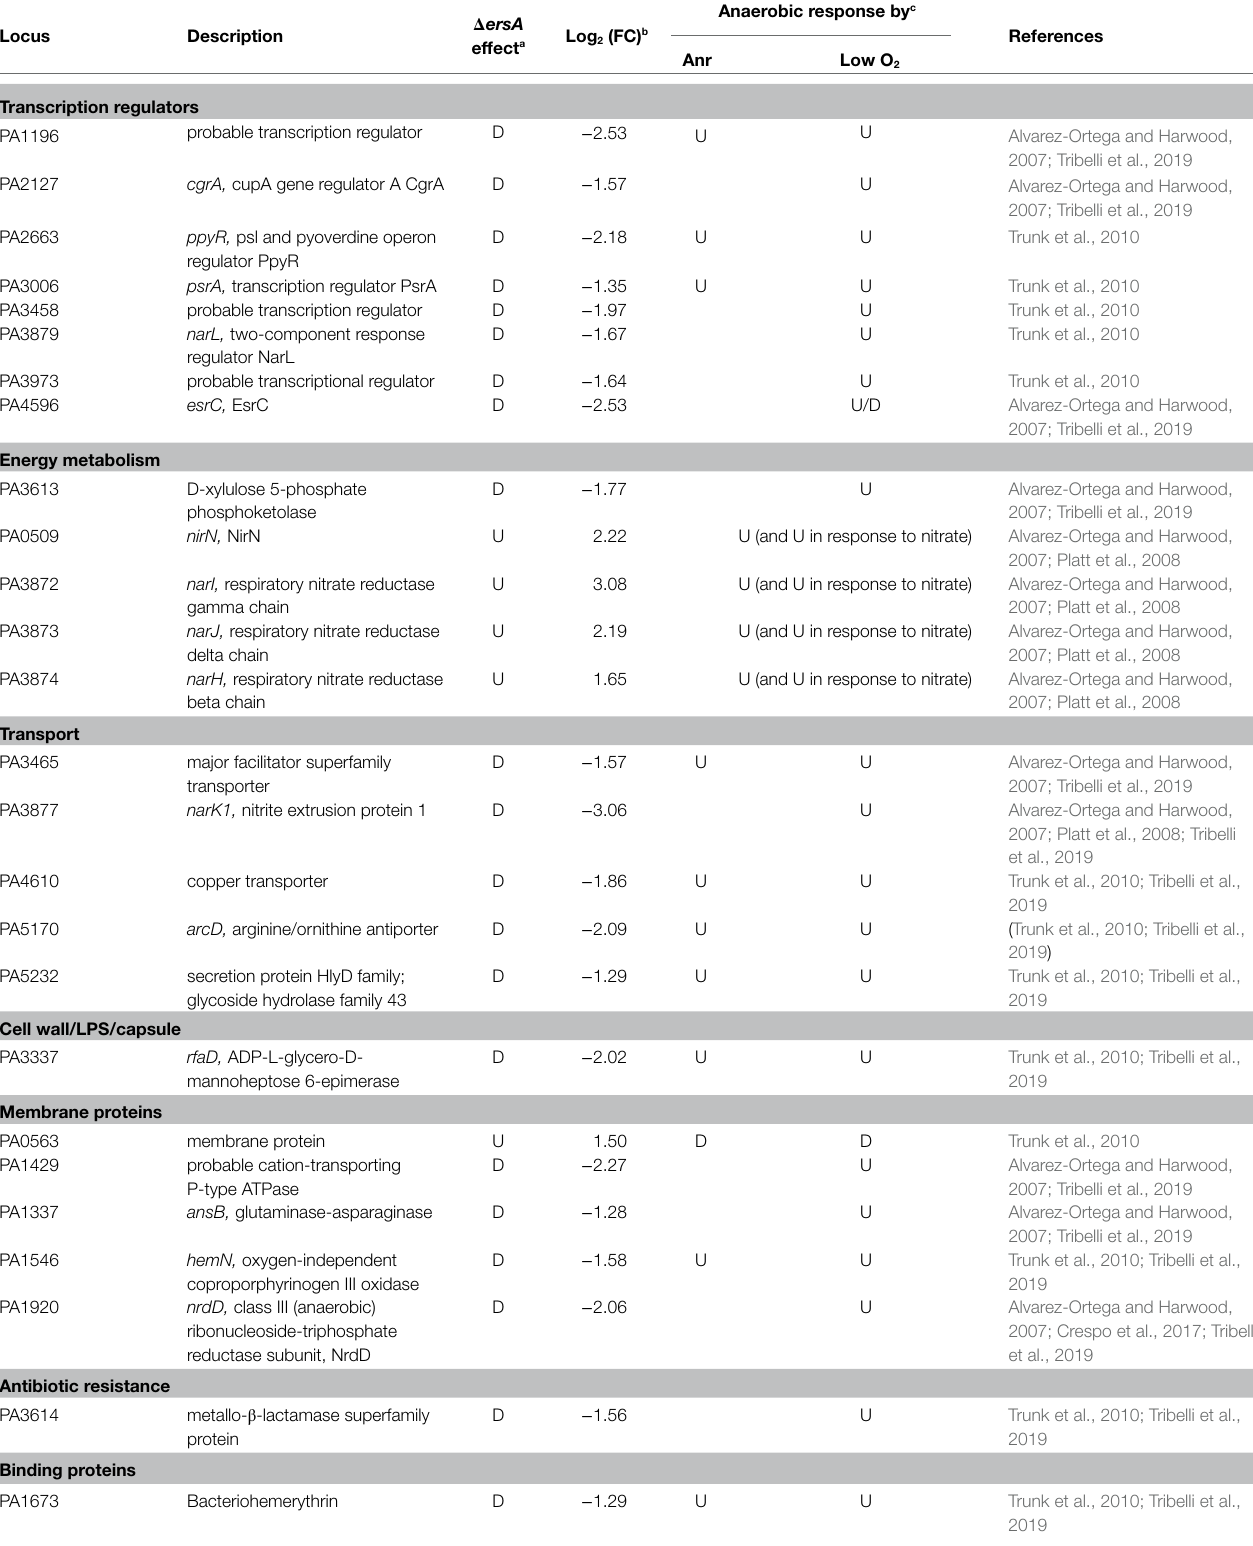
TABLE 1 | Differentially expressed genes (DEGs) in the PAO1 wild-type vs. the Δ ersA mutant strains belonging to regulons responsive to anoxic conditions.